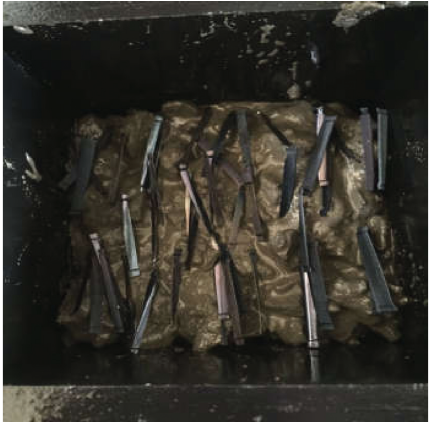
Figure 4: Photograph of the workability of the concrete mixture.